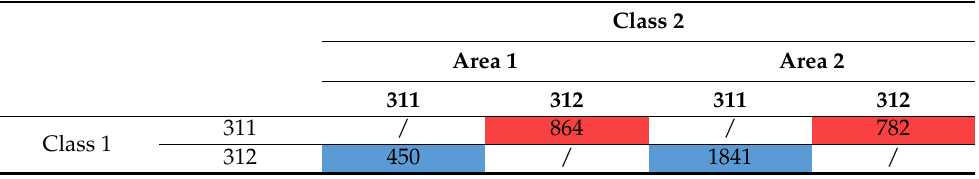
Table 5. Third level: best wavelength for two-class separability. In blue, the wavelength extracted